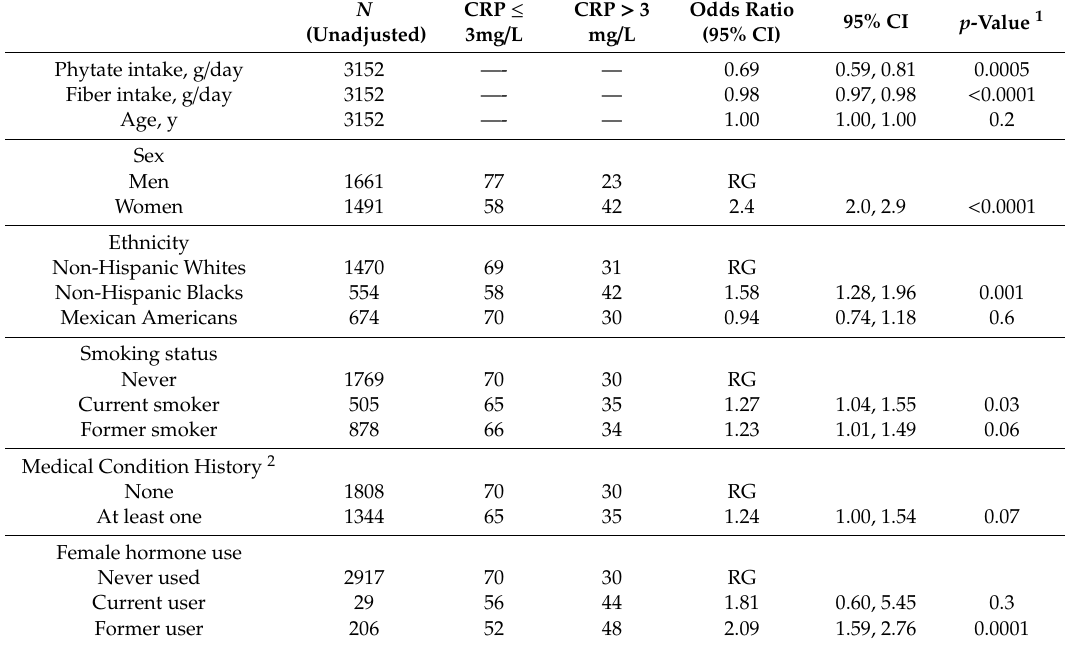
Table 3. Associations between phytate intake, demographic factors and odds of elevated C-reactive protein (CRP) concentration among subjects ≥ 20 years old with overweight or obesity as per the NHANES of 2009 / 2010. N